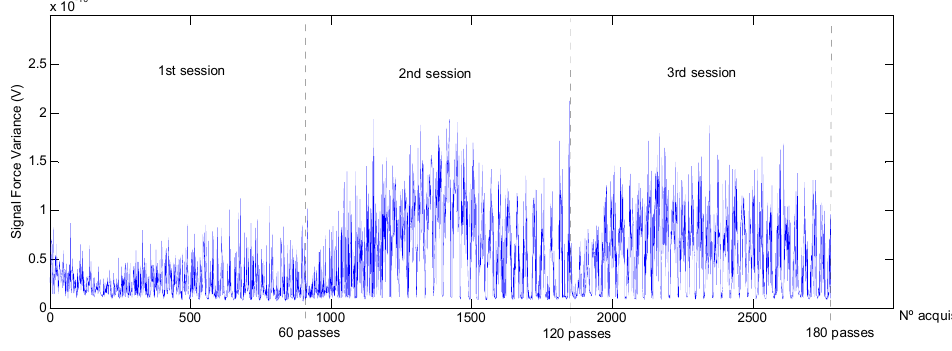
Figure 4. Signal forces variance ( F variance ) during the three polishing sessions.